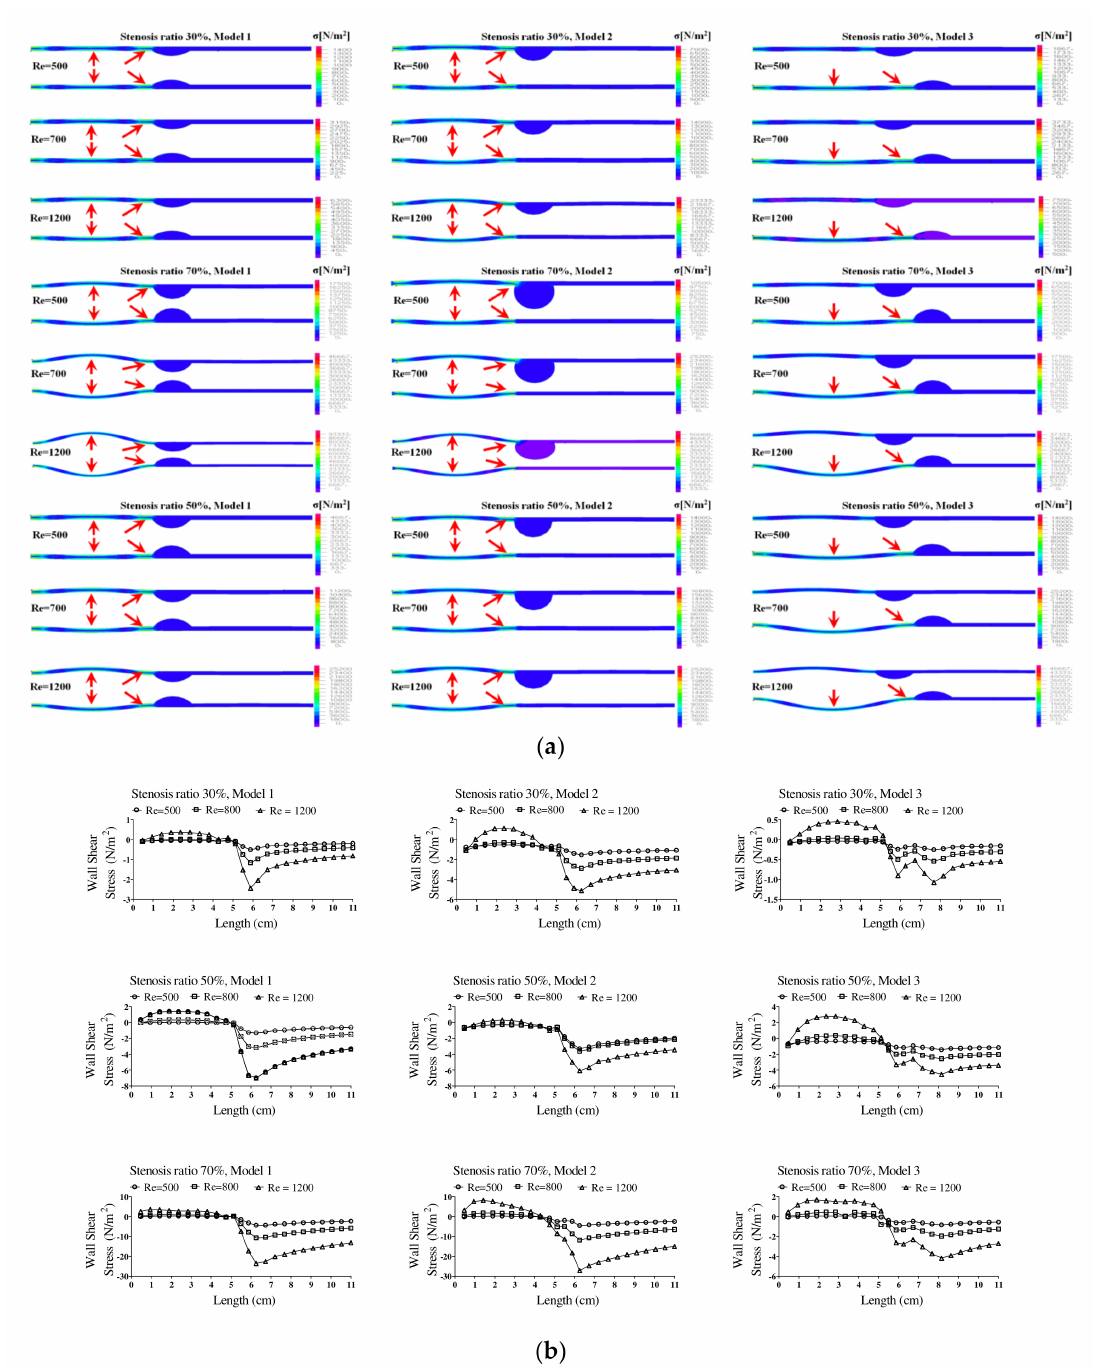
Figure 5. The wall load distribution and wall shear stress on the wall of blood vessels in the continuous flow. ( a ) Wall load distribution, ( b ) wall shear